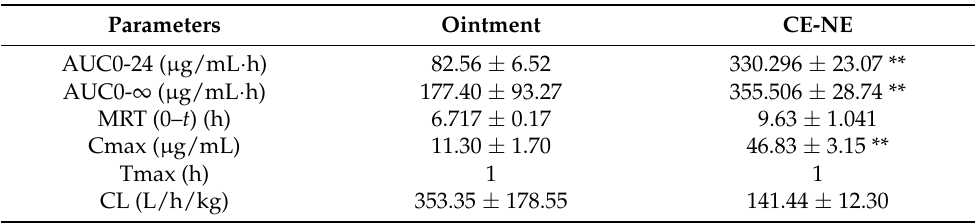
Table 7. Pharmacokinetic parameters of CE-NE and ointment after topical administration at a dose of 50 mg/kg in KunMing mice ( n =